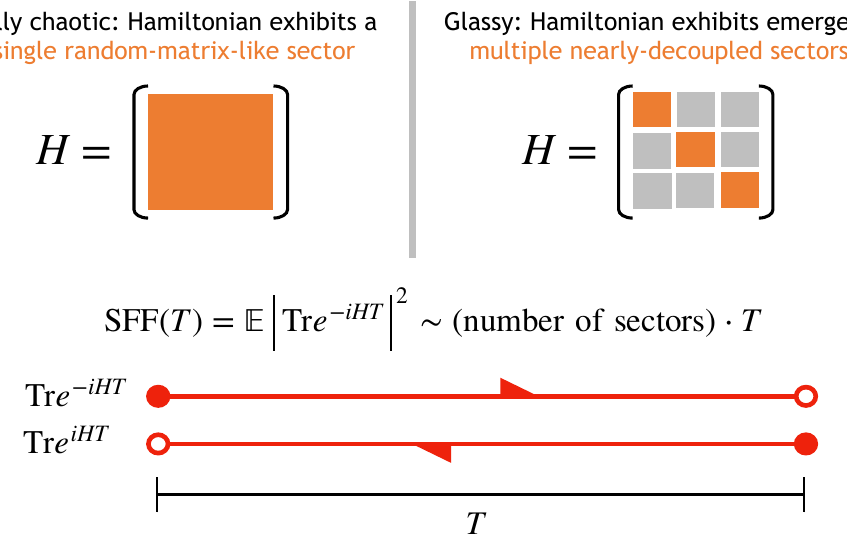
Figure 1 . (Top left) Fully chaotic systems have energy levels that are statistically similar to a Gaussian random matrix, indicated by the orange block. (Top right) By contrast, quantum spin glasses in the non-ergodic phase have spectral statistics that resemble a collection of many nearly-decoupled random matrices (Bottom) Spectral statistics can be diagnosed via the spectral form factor, denoted SFF ( T ) , which consists of a path integral over a pair of real-time contours as indicated by the red lines. The universal part of SFF ( T ) , which is proportional to T , is enhanced by the number of effectively uncoupled sectors (other non-universal contributions are not indicated here).